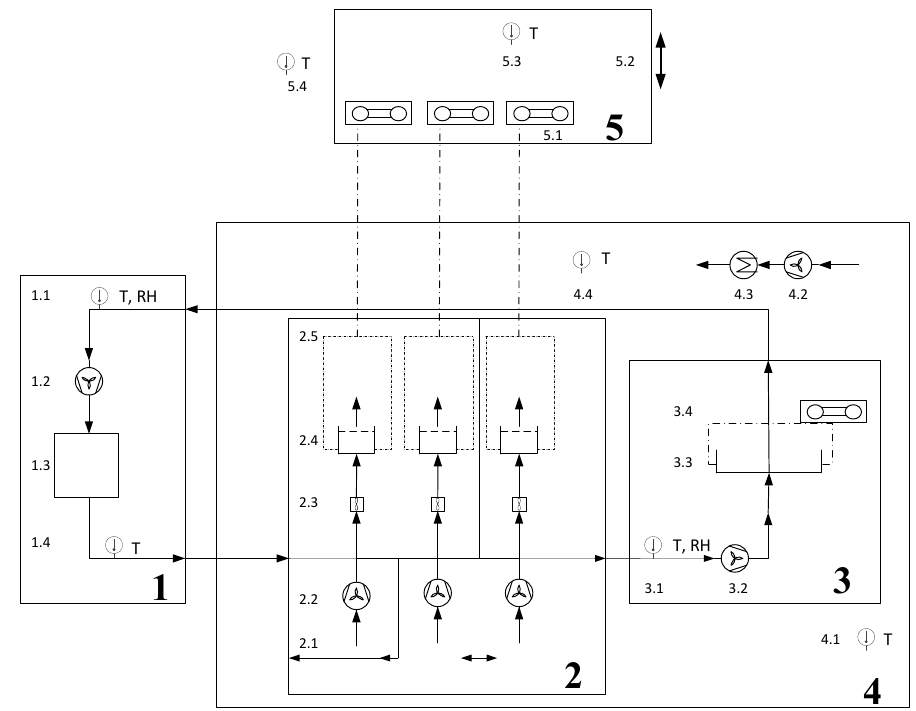
Figure 1. Schematic of the high-precision laboratory dryer HPD TP3+ (for legend, see Table 1).